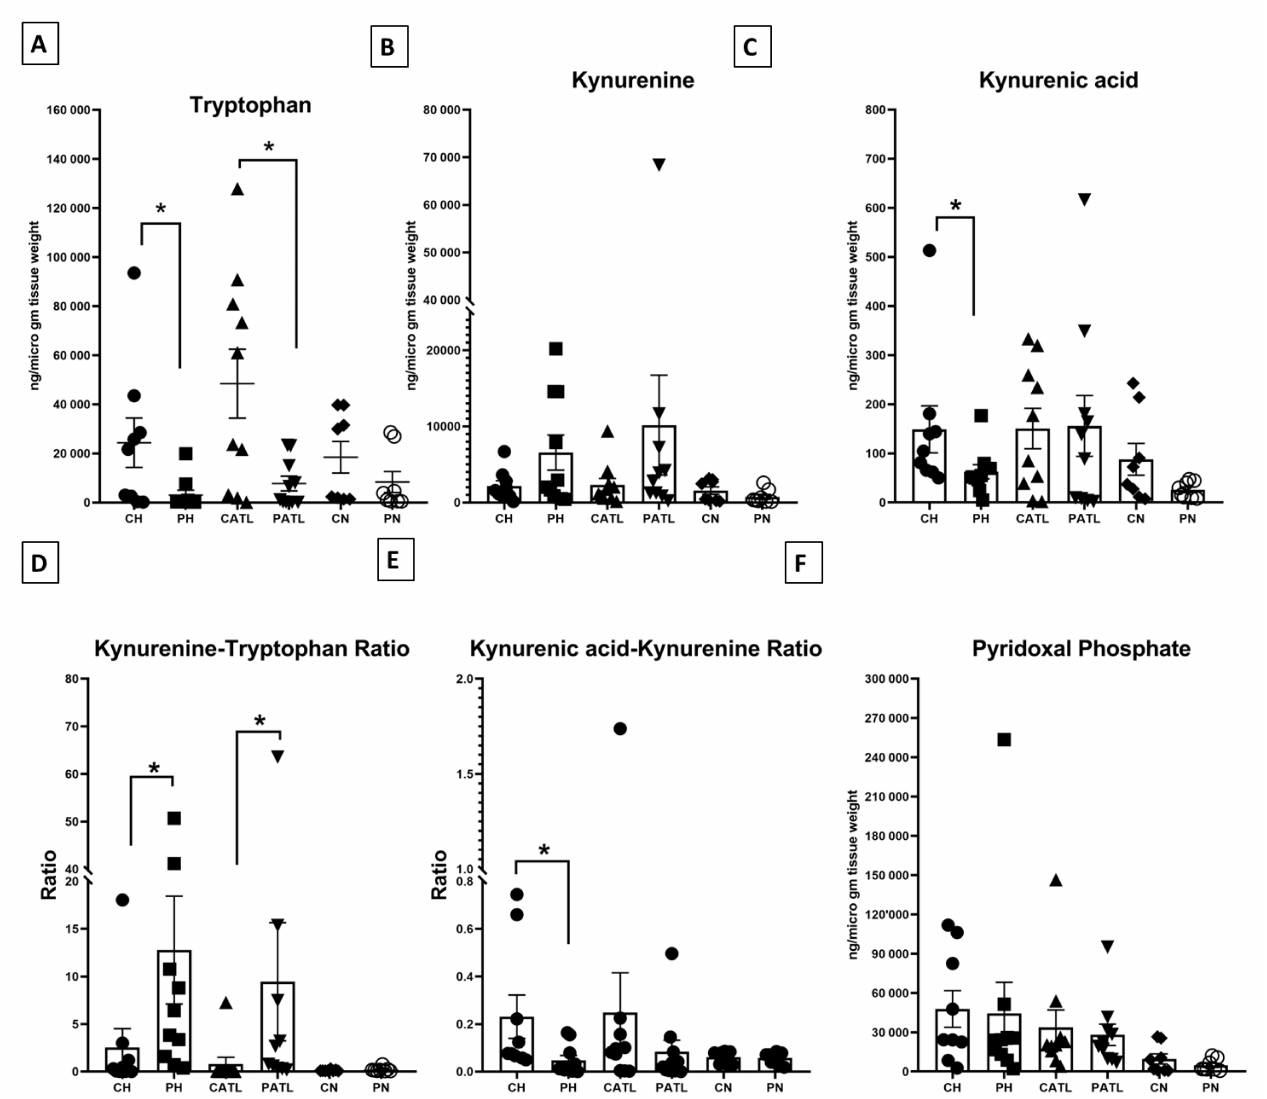
Figure 3. Quantitative estimation of tryptophan–kynurenine pathway metabolites. ( A ) Concentration of tryptophan, ( B ) concentration of kynurenine, ( C ) concentration of kynurenic acid, ( D ) kynurenine– tryptophan ratio, ( E ) kynurenic acid–kynurenine ratio, ( F ) concentration of pyridoxal phosphate. CH, control hippocampus (n = 9); PH, pilocarpine hippocampus (n = 10); CATL, control ATL (n = 10); PATL, pilocarpine ATL (n = 10); CN, control neocortex (n = 8); PN, pilocarpine neocortex (n = 8). Data represented as mean ± SEM; * p < 0.05, Mann–Whitney U